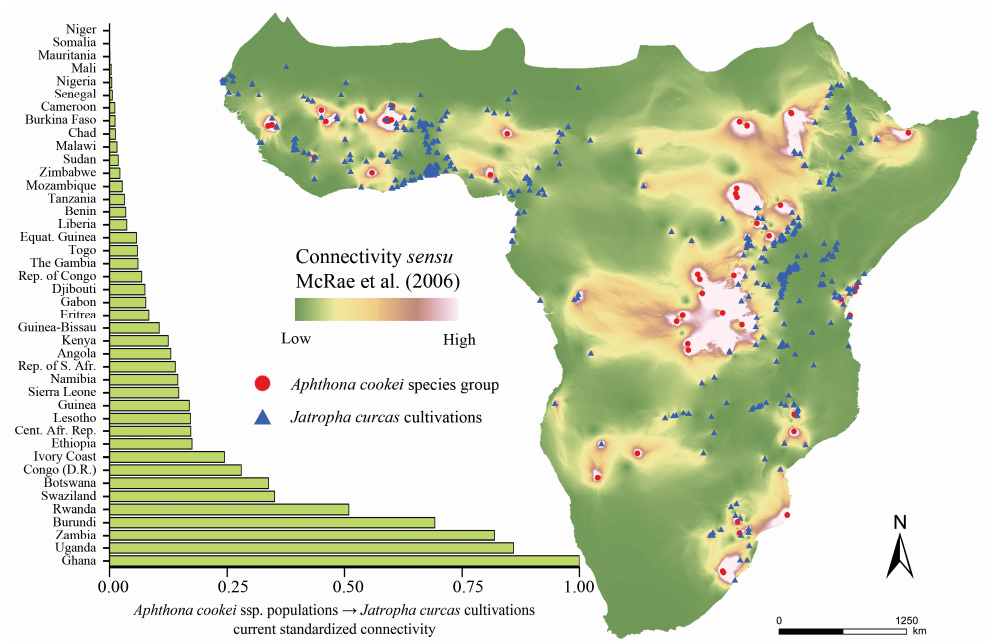
Figure 1. Connectivity among Aphthona cookei species complex populations and Jatropha curcas cultivations inferred for current climatic conditions.